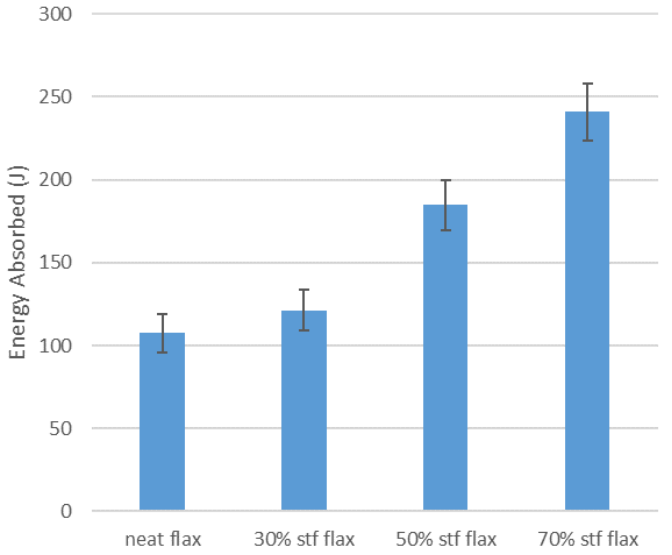
Figure 9. Comparison of ballistic impact energy absorption for flax fabric samples.